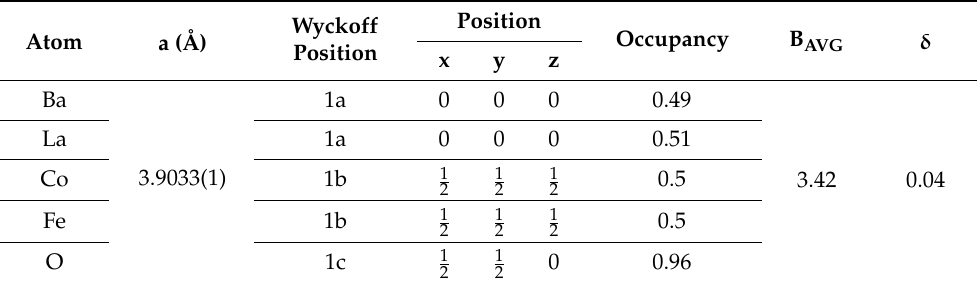
Table 3. Structural parameters obtained from the Rietveld refinement of the Ba 0.5 La 0.5 Co 0.5 Fe 0.5 O 3 − δ pattern along with iodometric titration